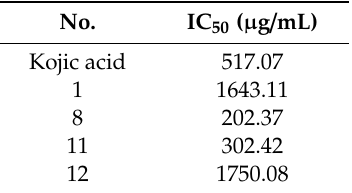
Table 9. Tyrosinase inhibitory activity inhibition test